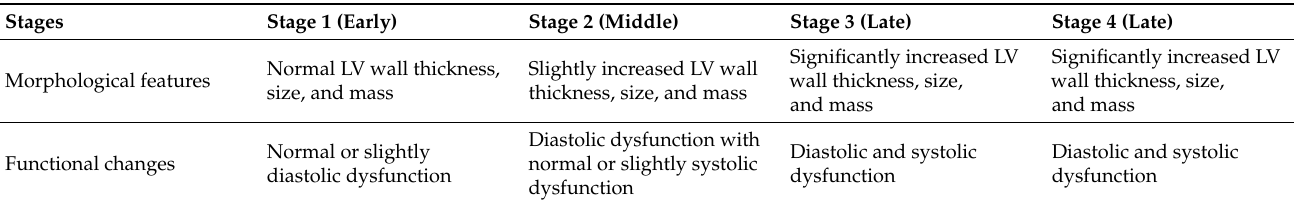
Table 1. Stages of diabetic